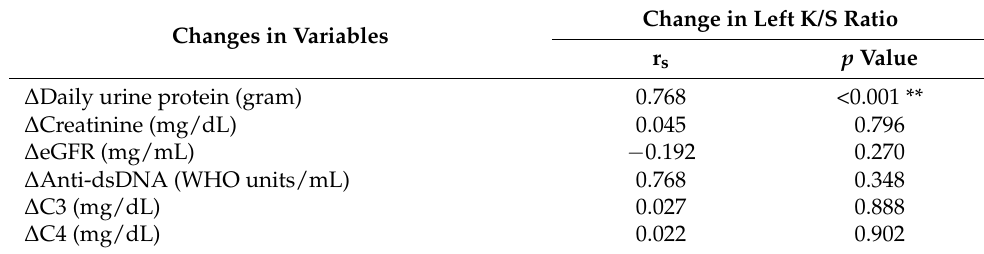
Figure 4. Renal gallium scan and renal histopathologic images of a 22-year-old male with lupus nephritis at diagnosis and two years after immunosuppressant treatment. This figure demonstrated that persistent undiminished gallium uptake was compatible with persistent active inflammation in renal histology and clinical proteinuria. ( a , b ) At diagnosis, renal pathologic active index score was 5. The Left K/S ratio was 1.22. Daily urine protein was 6.63 g/d. ( c , d ) Two years after immunosuppressant treatment, the activity index remained 5, left K/S ratio was 1.23 without diminished uptake, daily urine protein persisted at a high level of 5.89 g/d. L: left side; R: right side; K/S ratio: kidney/spine ratio; arrows: endocapillary hypercellularity. Table 4. Correlation of changes in clinical, pathologic parameters and change of renal gallium up- take in 35 SLE patients.